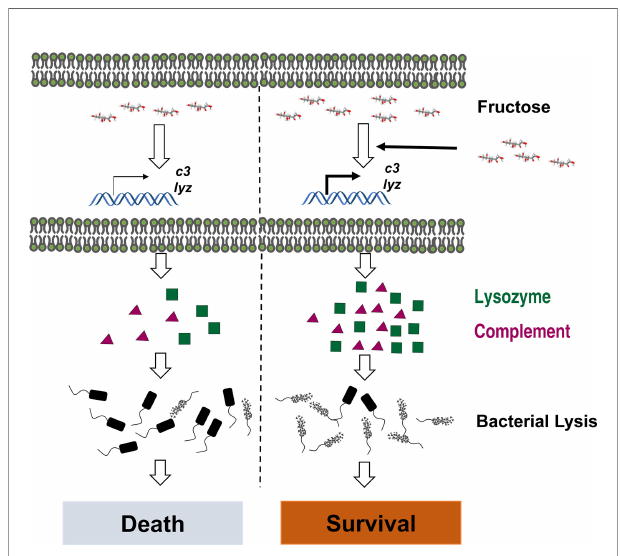
FIGURE 7 | Graph summary of fructose promoting crucian carp survival against A. hydrophila